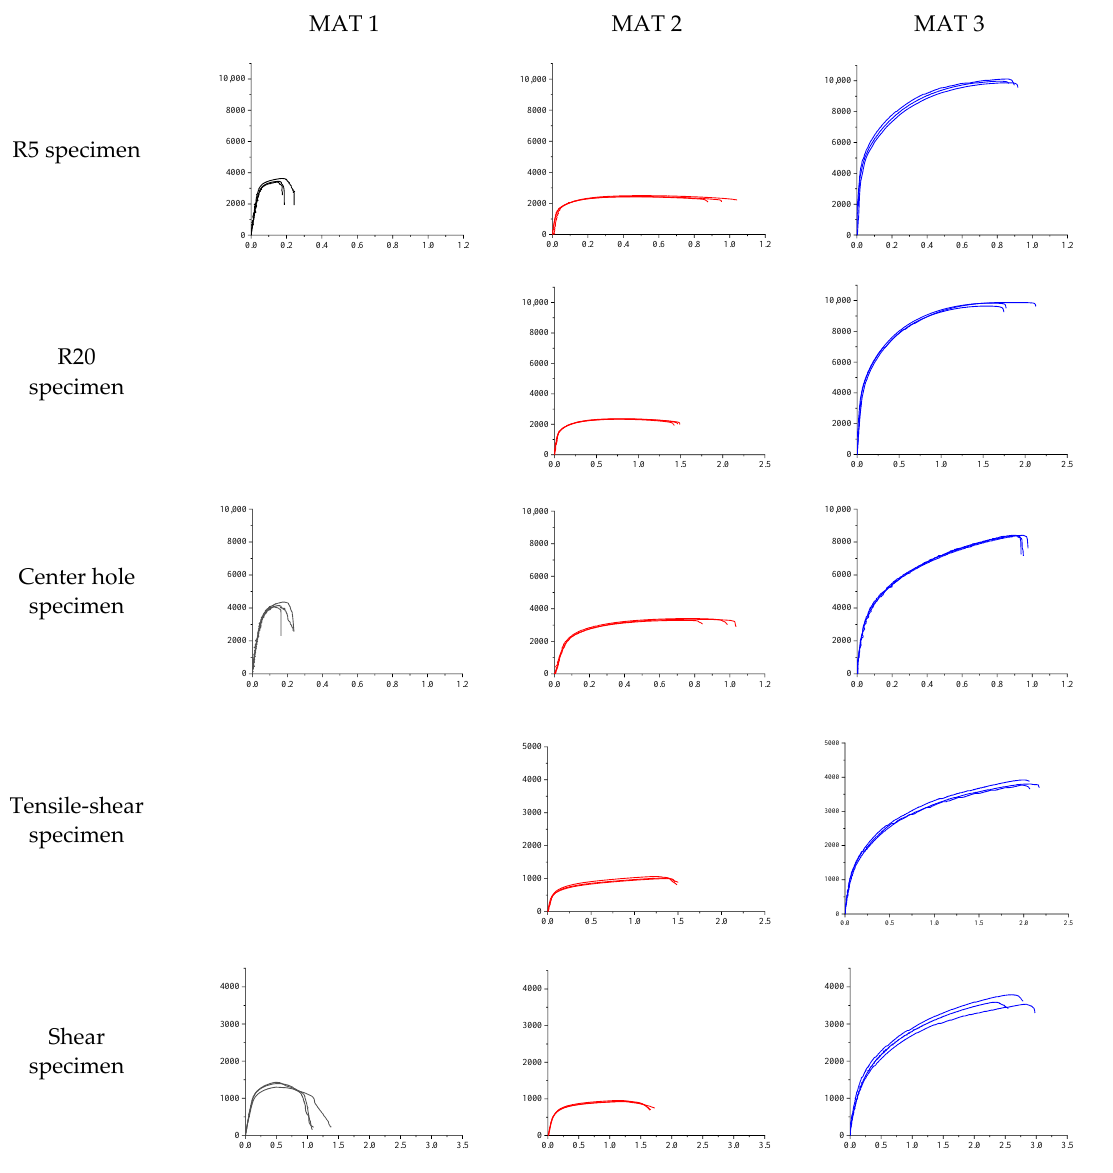
Figure 4. Experimental results (horizontal axis unit: mm; longitudinal axis: N).